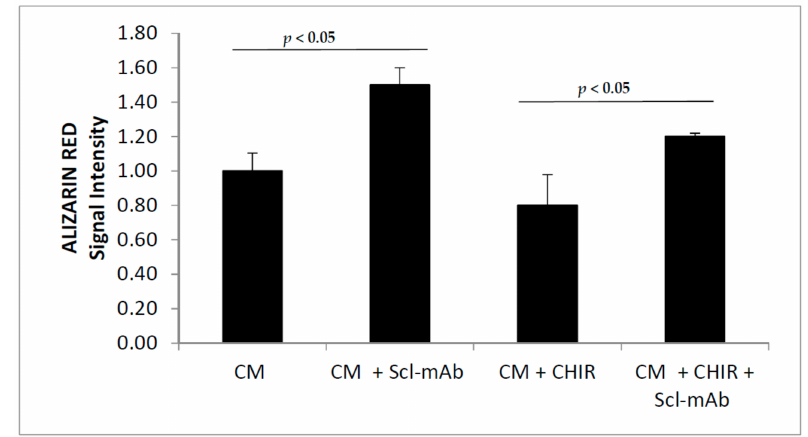
Figure 11. 2T3 osteoblast cells were maintained in differentiation medium for five days. The differentiating medium was added in a ratio of 1:4 with medium from MLO-Y4 (CM) that were previously treated with CHIR99021 (CM + CHIR) at 100 nM for 48 h. Where indicated, MLO-Y4 media were pre-treated with Sclerostin antibody for 3 h at 37 ◦ C